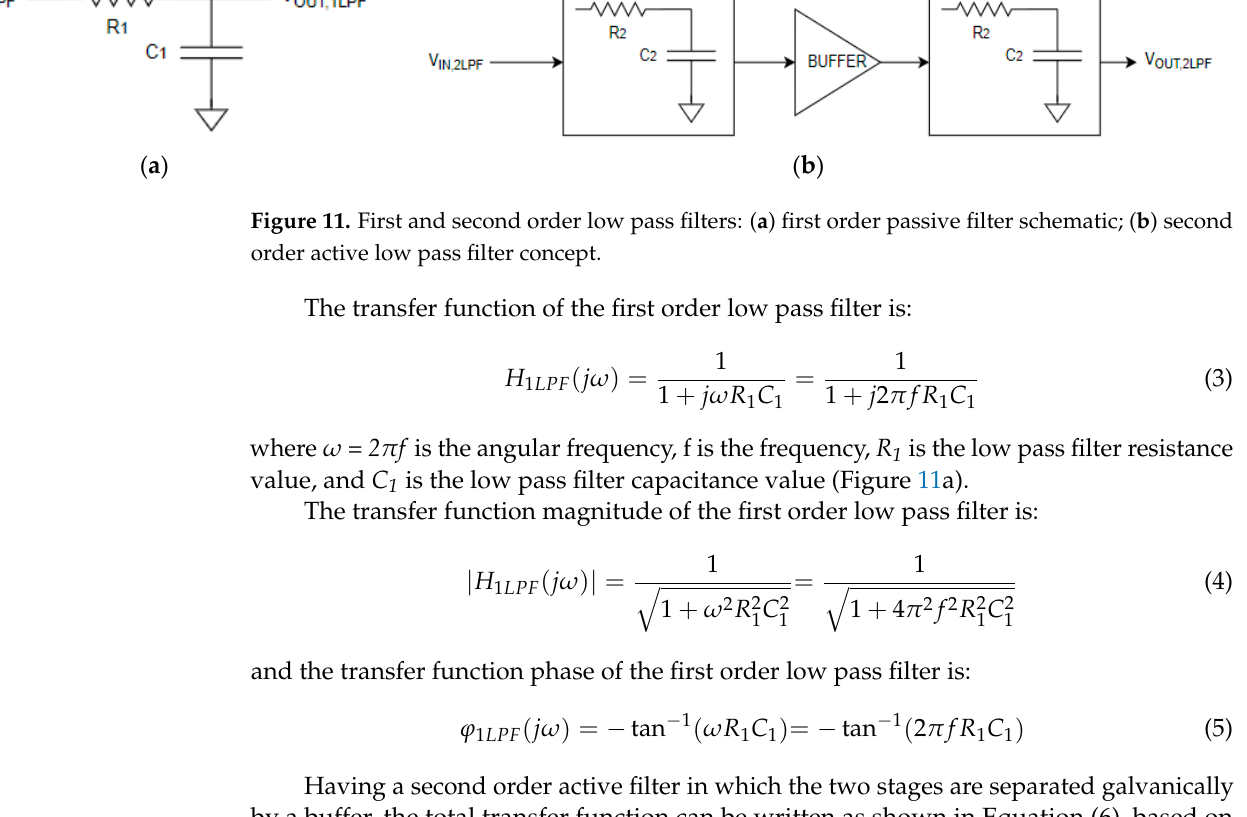
8 of 16 Figure 10. New LDO PSRR model concept. In Figure 10, the PSRR source V PSRR holds the information about the input voltage source ripple Δ V